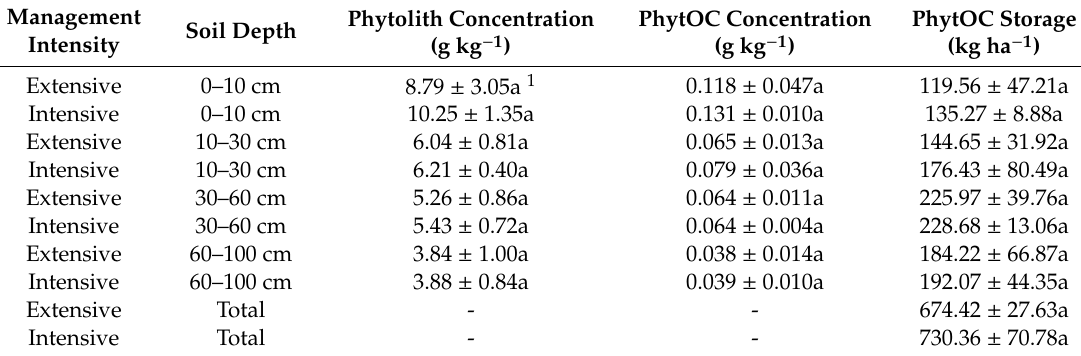
Table 2. Soil phytolith and PhytOC concentrations and storage (means ± standard deviations) in different soil layers under P. pubescens stands with different management intensities ( n = 3).